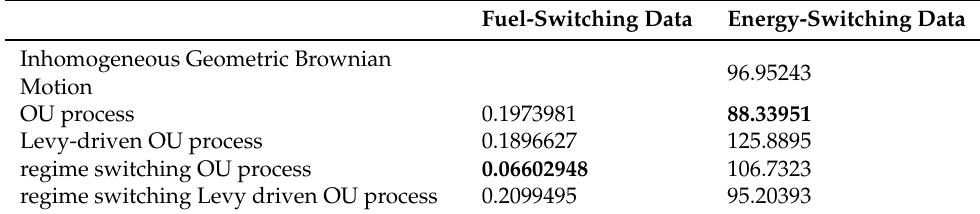
Table 12. The h-block cross-validation result for each model on both